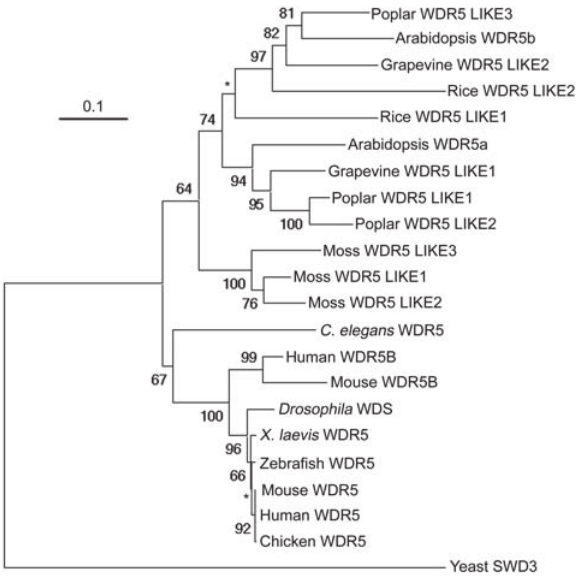
Figure 1. Phylogenetic Tree for WDR5 Homologs from Representative Plant and Animal Species. The tree of full-length WDR5 homologs was constructed by the Neighbor-Joining method using PHYLIP. Bootstrap values are shown for clades with a support greater than 60% (in 1000 sampling replicates). Star indicates a clade without a strong bootstrap support. The protein accession numbers are specified in Table S1.